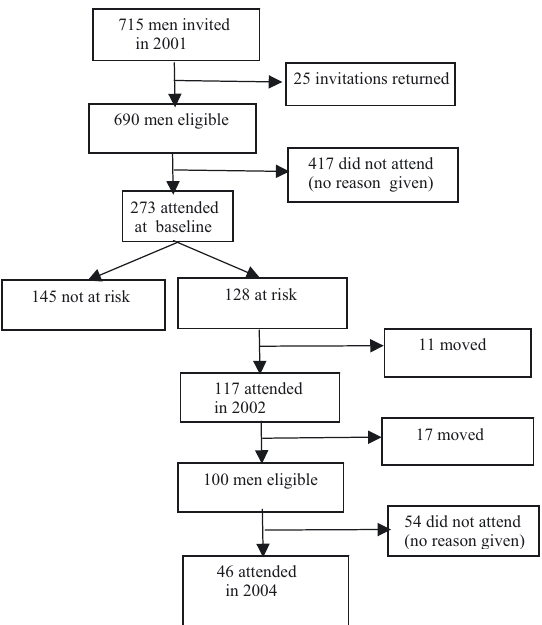
Figure 1. Profile of 3-year-follow-up